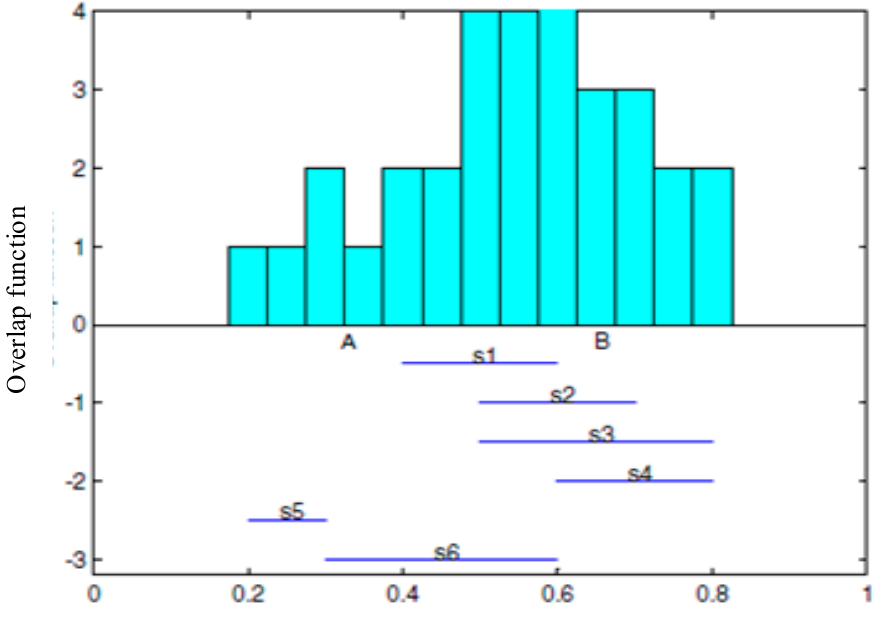
Figure 8. Abstract interval estimation.